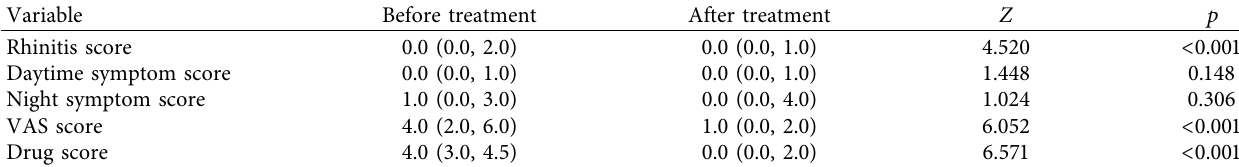
Table 5: Comparison of scores in the multiple allergy group before and after treatment.